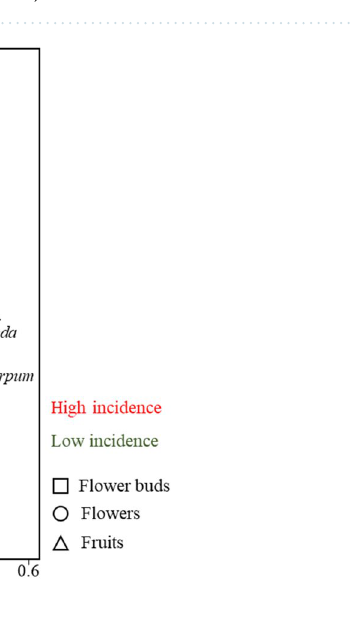
Figure 5. Principal component analysis (PCA) of endophytic fungal community inhabiting flower buds, flowers and fruits of olive tree growing in orchards with high incidence (High incidence) and low (Low incidence) incidence of olive anthracnose. This analysis was performed with preselected fungal OTUs by the random forest